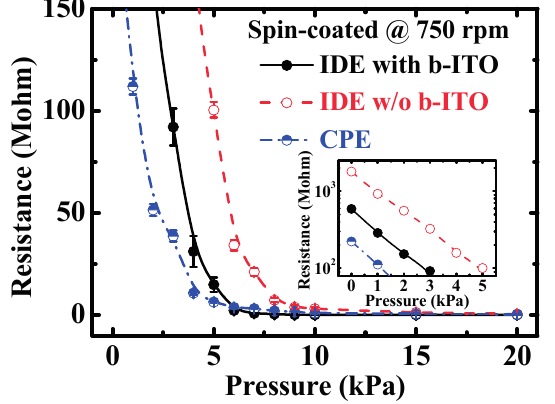
Figure 3. The resistance versus pressure ( R-P) characteristics of the poly(3,4- ethylenedioxythiophene):polystyrene sulfonate (PEDOT:PSS) pressure sensors with inter-digitated electrode (IDE) and cross-point electrode (CPE) structures. The spin speed of 750 rpm was used to coat PEDOT:PSS film and at least 20 samples were measured to obtain the statistical distribution. The inset shows the low-pressure properties of these pressure